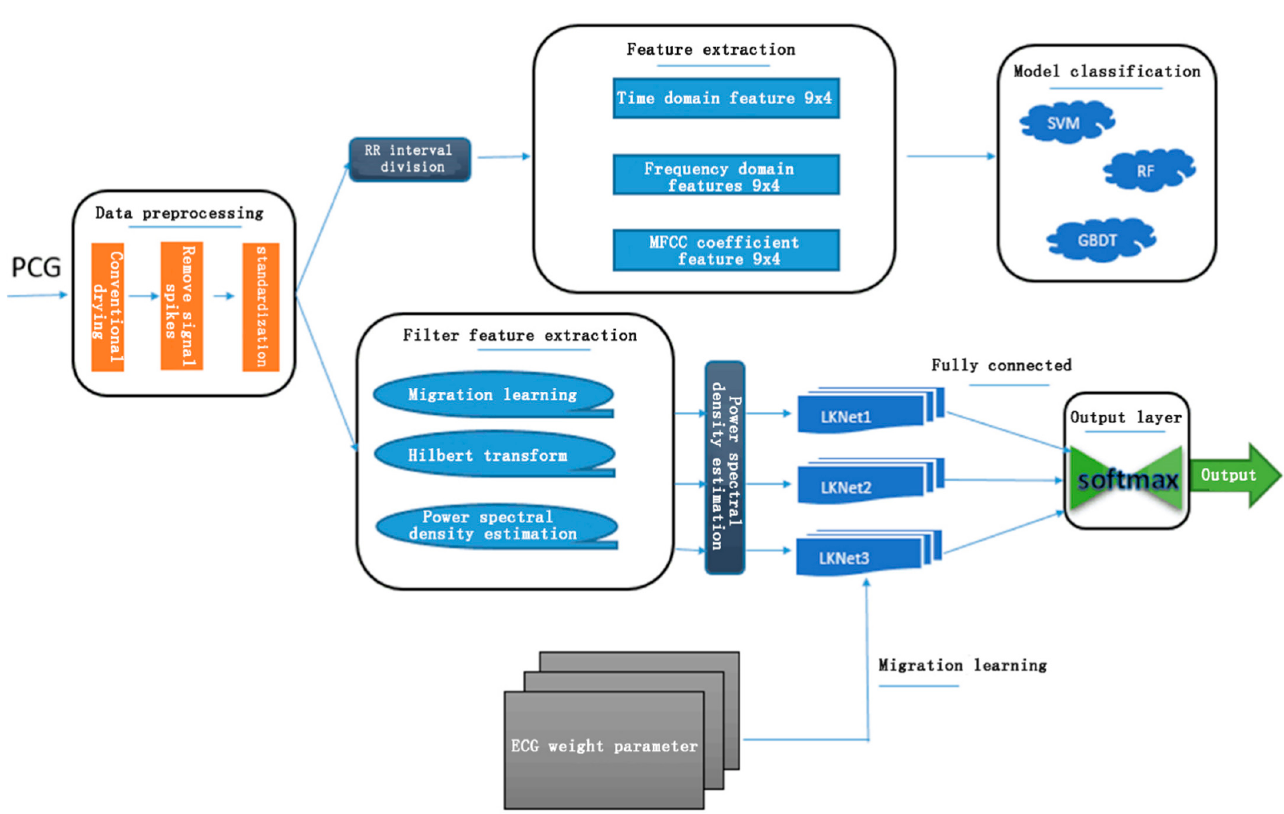
Figure 1. Framework for phonocardiogram (PCG) algorithms.